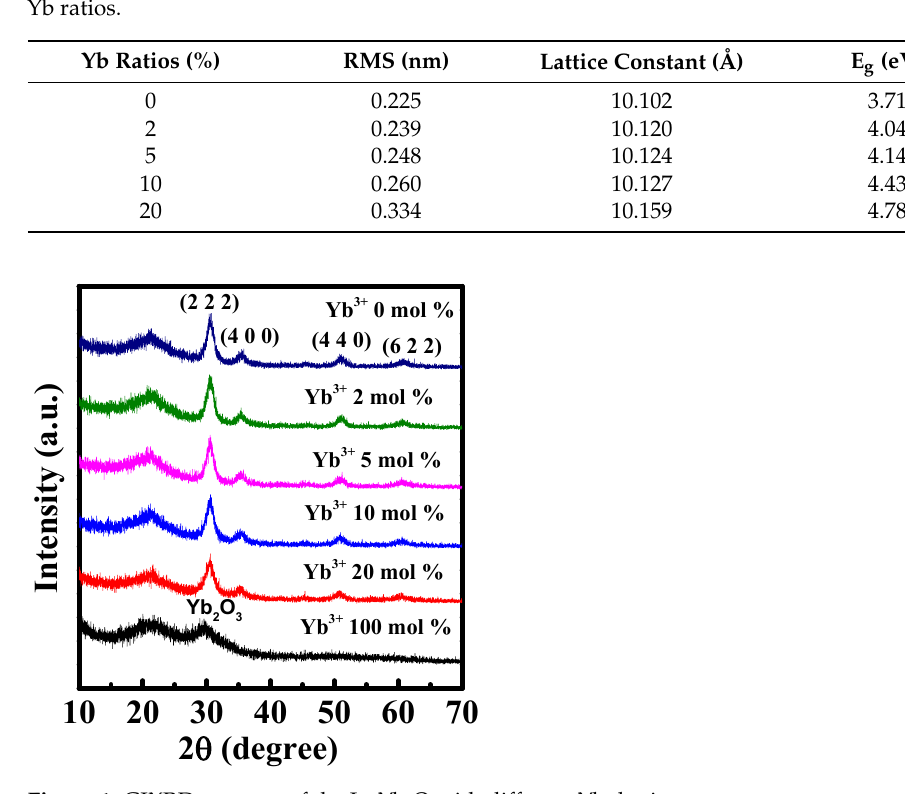
Figure 1. GIXRD patterns of the In-Yb-O with different Yb doping contents.